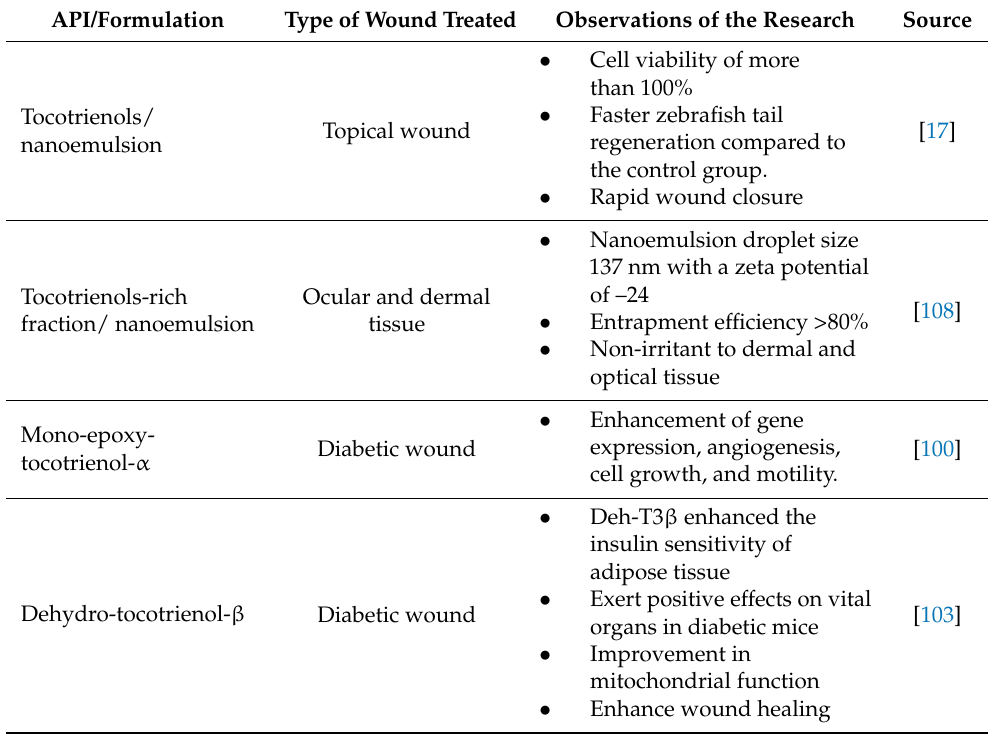
Table 2. Glimpses of research conducted to investigate the potential of tocotrienols on the